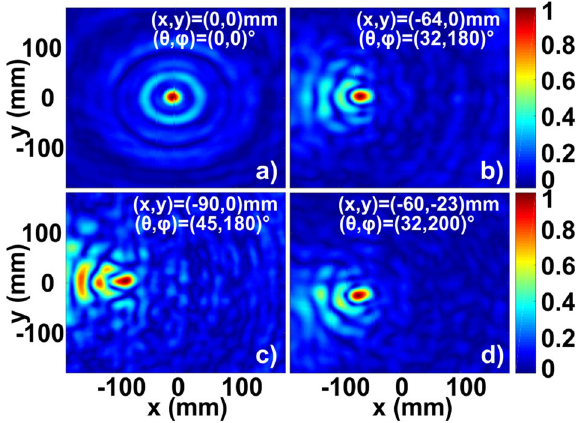
Figure 6. Experimental results—field intensity distributions (normalized to maximum) at the focal plane. The angle of incidence and the focal spot location are indicated in the legends.